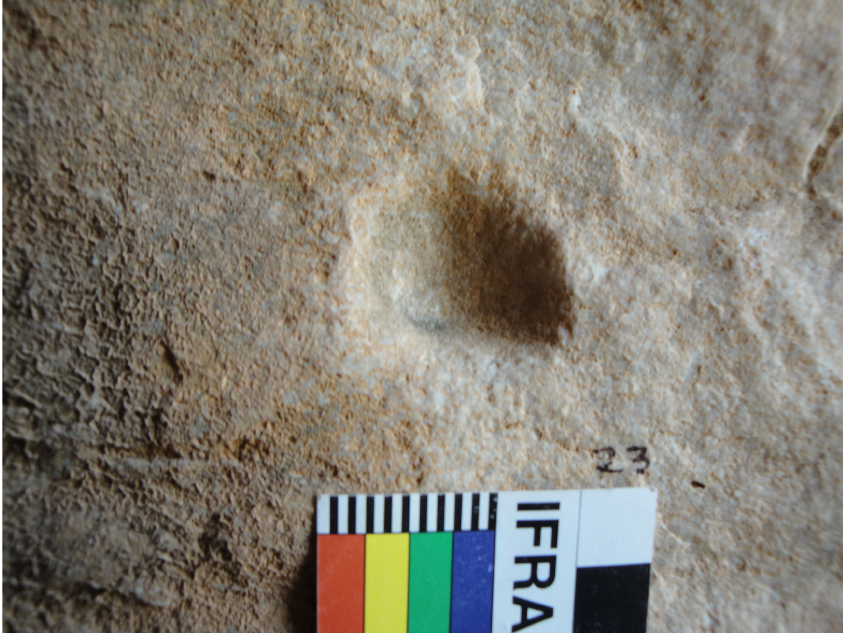
Figure 10. Small cupule with roughly triangular periphery and depth on southern wall in